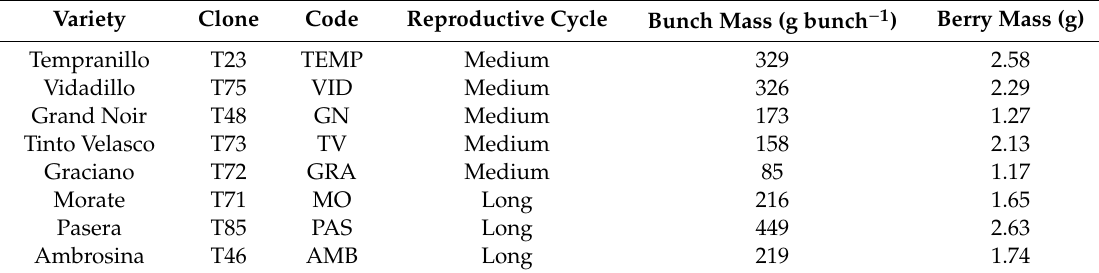
Table 1. Summary of the agronomic characteristics of the ancient grapevine varieties used in this study. Data provided by the Estaci ó n de Viticultura y Enolog í a de Navarra (EVENA) (Olite, Spain) were collected in 2018 from plants grown in the